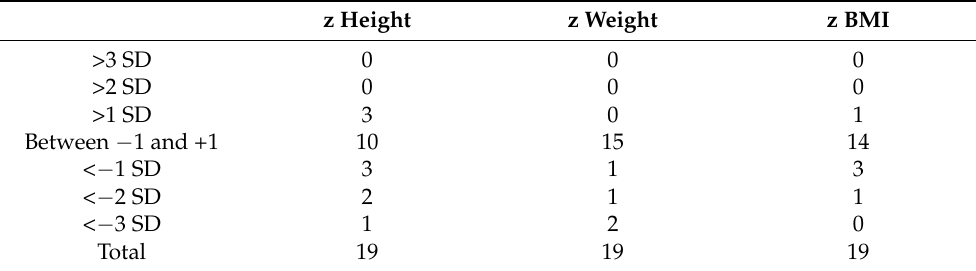
Table 2. Summary of weight, height and BMI z-scores of the children in the study. z Height z Weight z BMI >3 SD 0